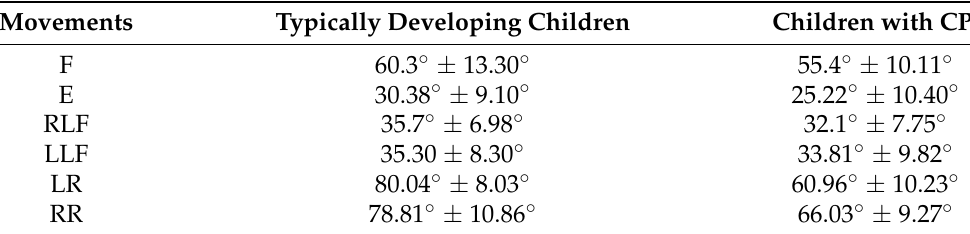
Table 2. Mean values and standard deviations of CROM for the